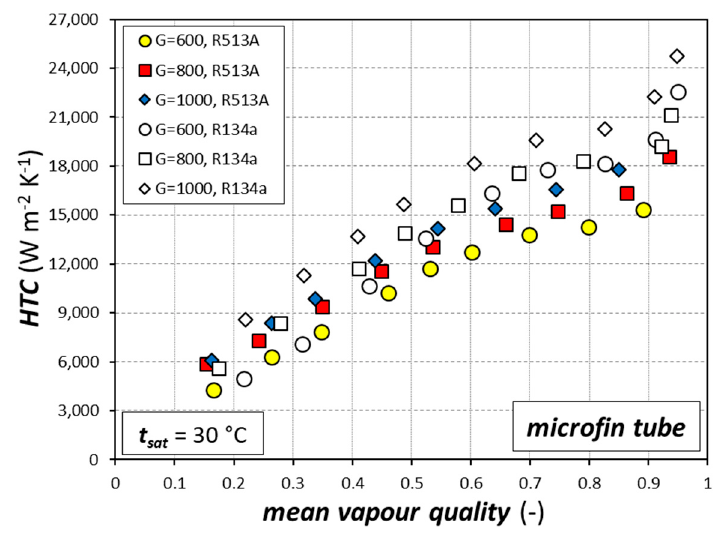
Figure 9. R134a and R513A heat transfer coefficient during condensation for the microfin tube vs. mean vapor quality at t sat = 30 °C. G expressed in [kg m − 2 s − 1 ].